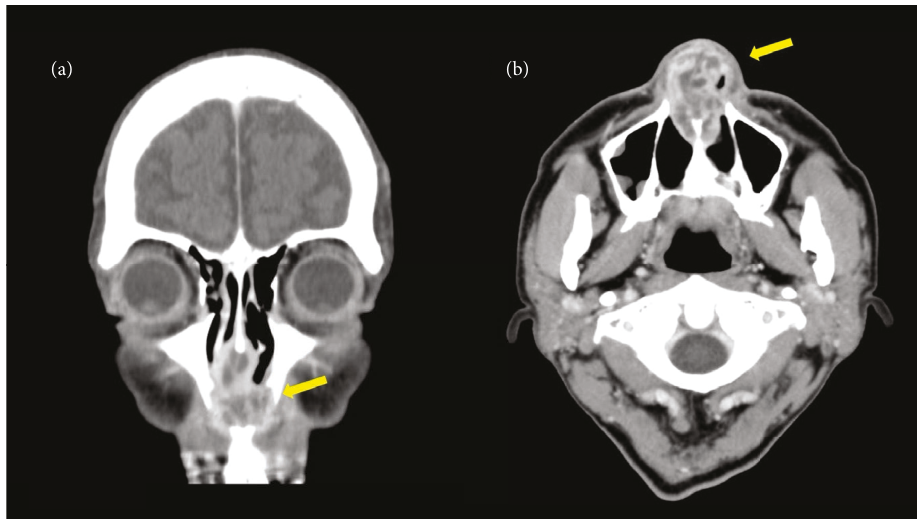
Figure 2: (a). Coronal contrast-enhanced CT of the paranasal sinuses showing multifocal abscess in the nasal septum (yellow arrow). (b). Axial contrast-enhanced CT of the paranasal sinuses showing multifocal abscess in the nasal septum (yellow